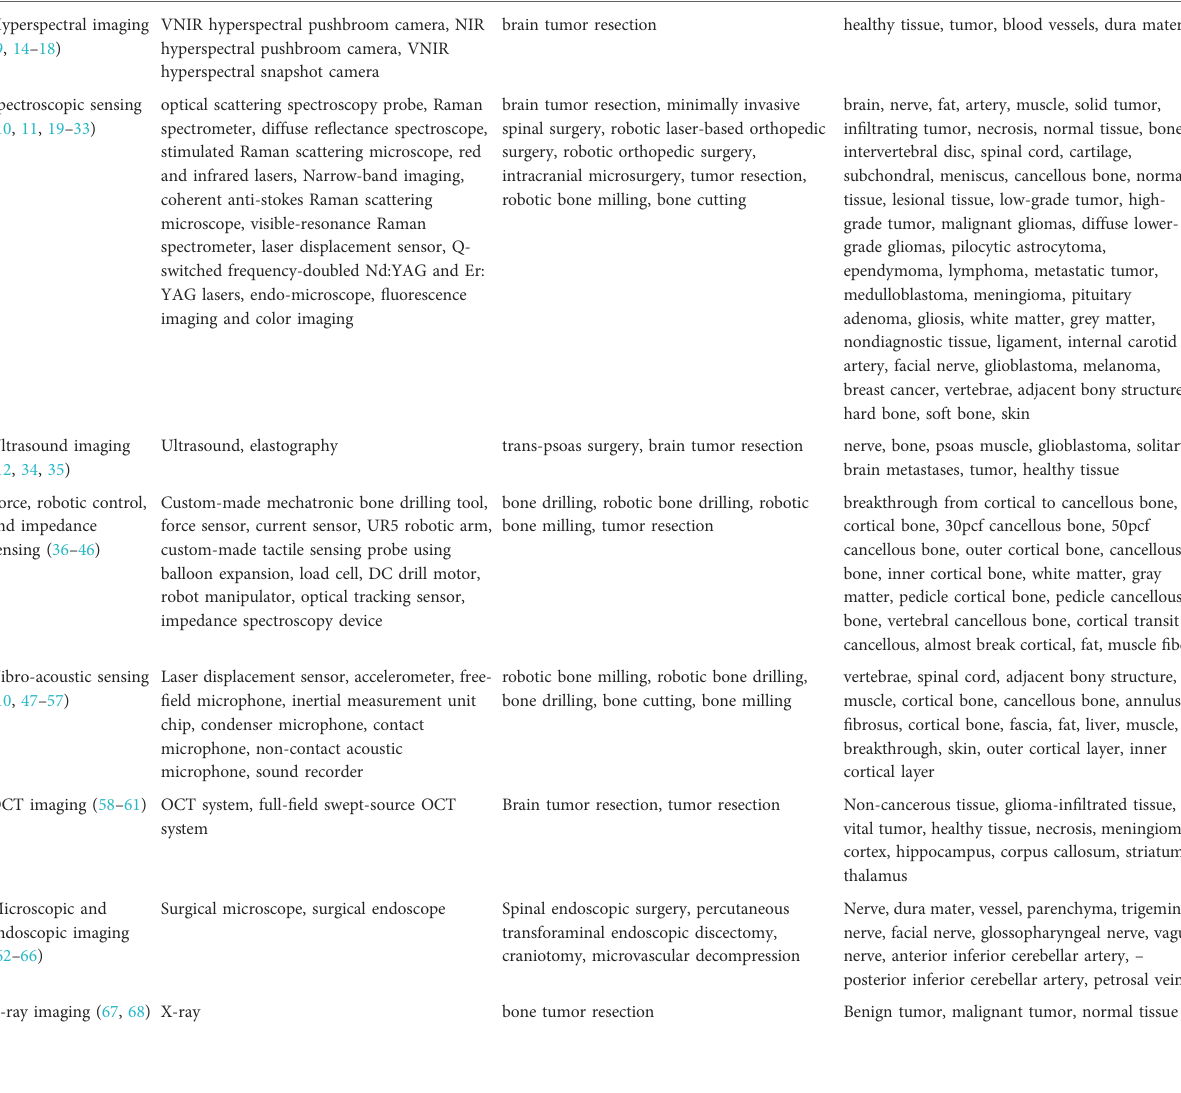
TABLE 1 General overview of sensing technologies. Category